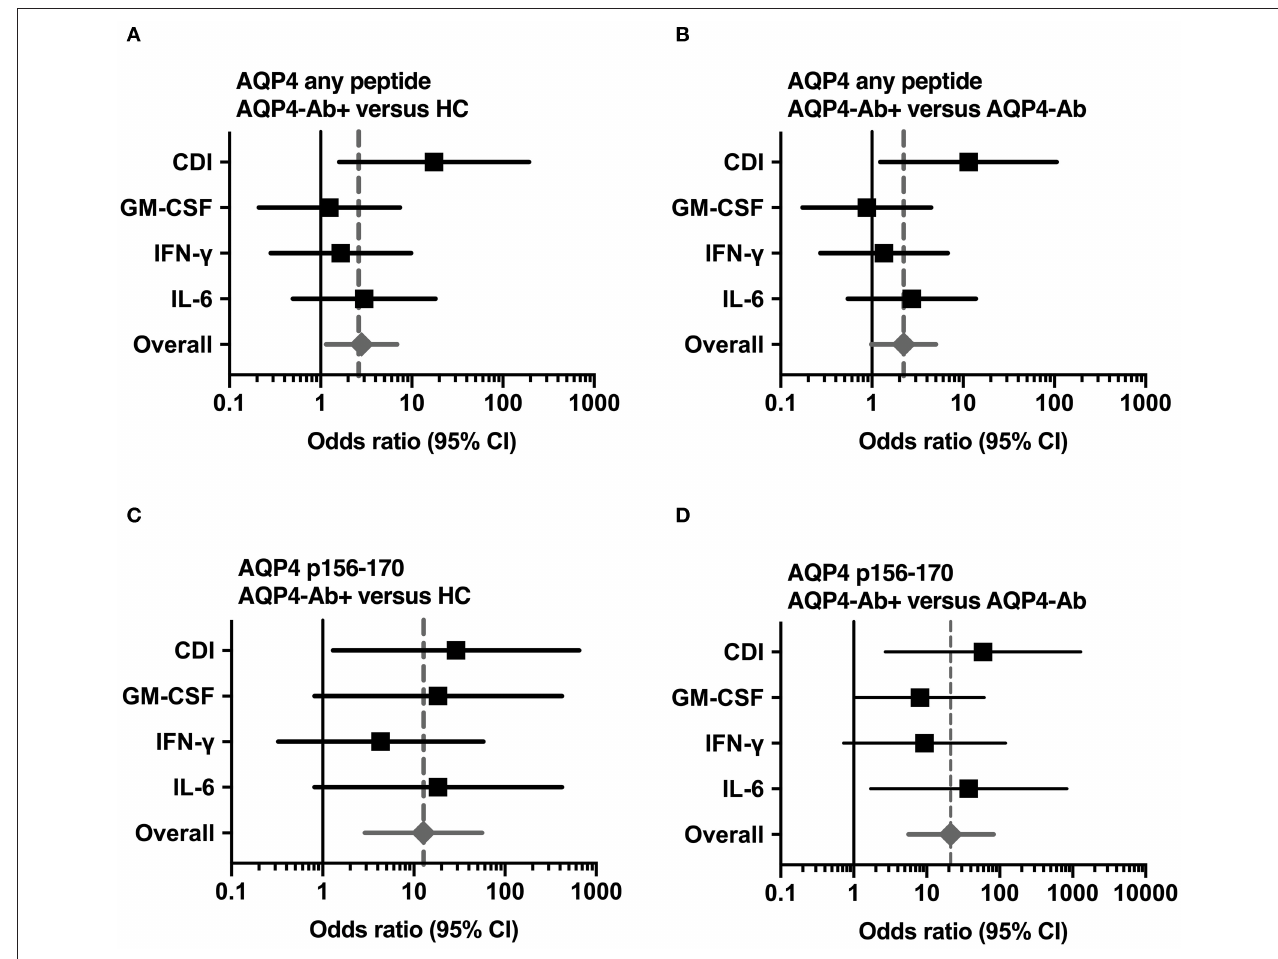
FIGURE 5 | Significant CD4 + T-cell reactivity to AQP4 peptides. Forest plot displaying Mantel-Haenszel common odds ratio estimates (symbols) with asymptomatic 95% CI (horizontal lines) for response to AQP4 peptides. (A) Reactivity against at least one AQP4 peptide, comparison of patients with AQP4-Ab ( n = 8) vs. HC ( n = 14). (B) Reactivity against at least one AQP4 peptide, comparison of patients with AQP4-Ab ( n = 8) vs. all AQP4-Ab negative participants ( n = 29). (C) Reactivity against AQP4 p156-170, comparison of patients with AQP4-Ab ( n = 8) vs. HC ( n = 14). (D) Reactivity against AQP4 p156-170, comparison of patients with AQP4-Ab ( n = 8) vs. all AQP4-Ab negative participants ( n = 29). AQP4-Ab + , aquaporin-4 antibody positive; AQP4-Ab-, aquaporin-4 antibody negative, CDI, cell division index; CI, confidence interval; GM-CSF, granulocyte-macrophage-colony-stimulating factor; HC, healthy controls; IFN, interferon; IL,